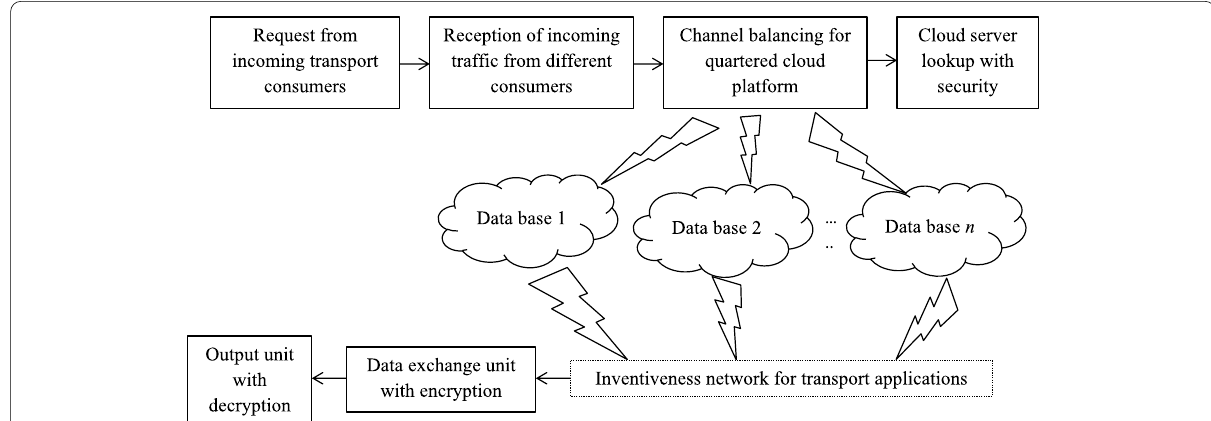
Fig. 1 Block diagram of multiple cloud system for transportation